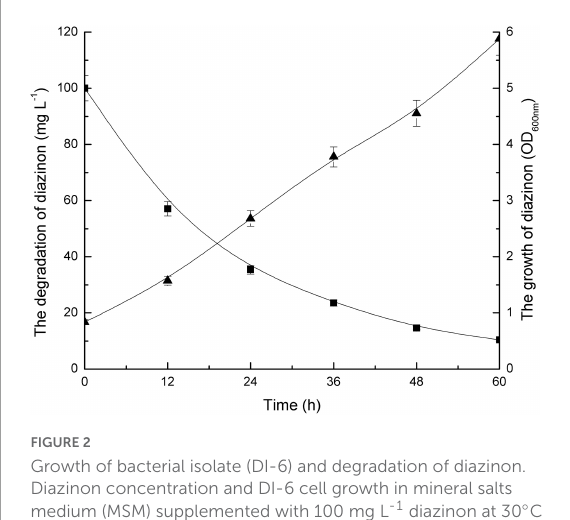
FIGURE3 Effect of initial substrate concentrations on the biodegradation of diazinon by DI-6. Error bars, mean ± SD of three replicates. Each symbol represents the substrate concentration of diazinon; Square: 100 mg L − 1 of diazinon was added; Circle: 200 mg L − 1 of diazinon was added; Upper triangle: 300 mg L − 1 of diazinon was added; Lower triangle: 400 mg L − 1 of diazinon was added; Left triangle: 500 mg L − 1 of diazinon was added.